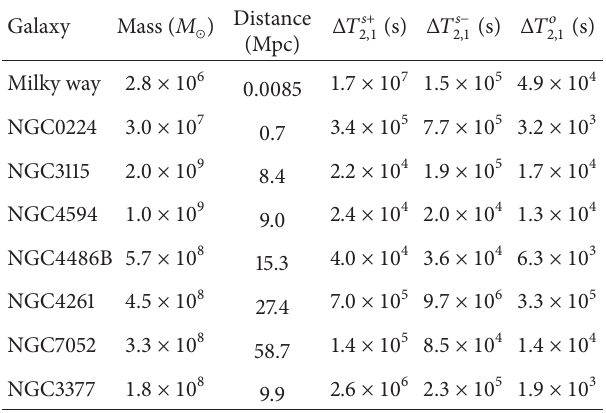
Table 8: Estimation of time delays of the supermassive BHs located at the center of galaxies for phantom global monopole ( 𝜉 = −1 ) with 𝜂 = 0.05 . Galaxy